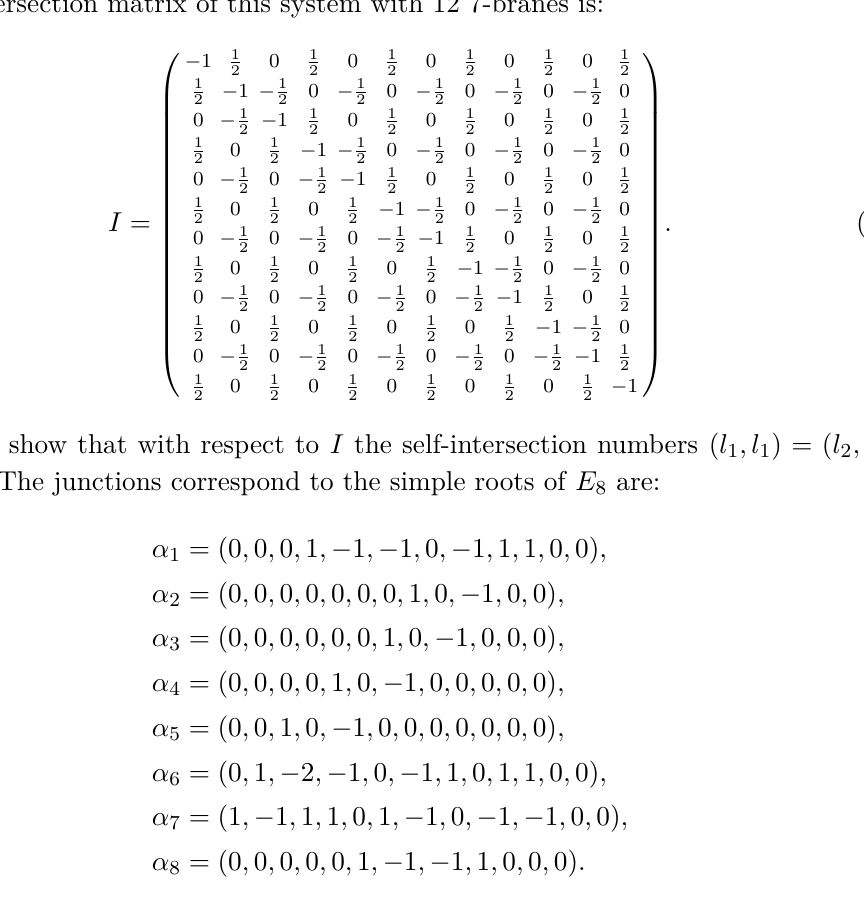
Figure 10 . The E 8 branes obtained from the grouping together the E 6 gauge branes and the extra π 1 and π 3 branes are denoted by the big black point. l 1 is a junction that loops around the E 8 branes and a π brane with charge a ( l ) = (1 , 0) . l is a junction that loops around the E 3 1 3 and a π brane with charge a ( l ) = (0 , 1) . l is a junction that loops around all the 12 7-branes 1 3 2 with charge a ( l ) = (1 , 1) 2